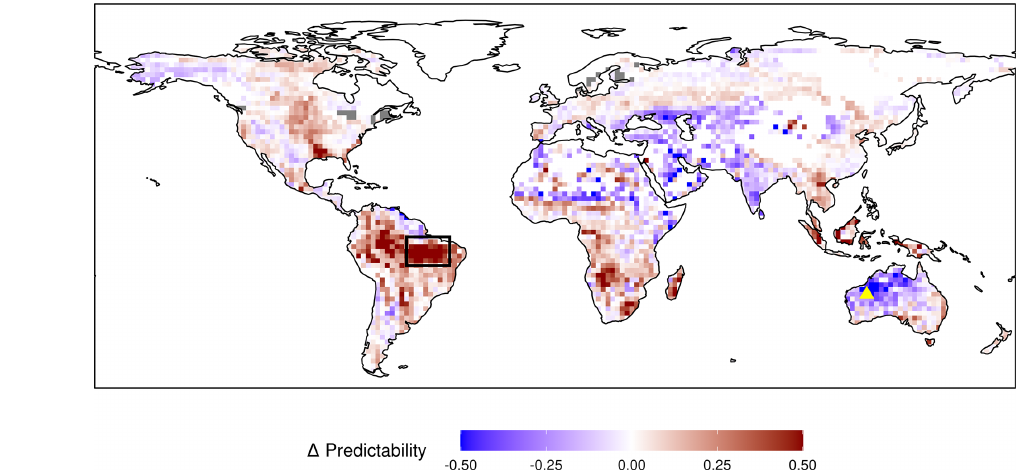
Figure 7. Difference in NPP predictability ( V c ) based on the initial soil moisture. The mean NPP predictability of the first year from the 20% driest initializations are subtracted from the 20% wettest initializations for every grid cell. Red colour means higher NPP predictability in wet years and blue colour a higher predictability in dry years. Soil moisture from 19–78cm depth is used to determine initial conditions. A large fraction of years included in the initializations are ENSO years, where the initial anomaly is further extended through persisting oceanic forcing. The black box and yellow triangle stand for regions examined in the main